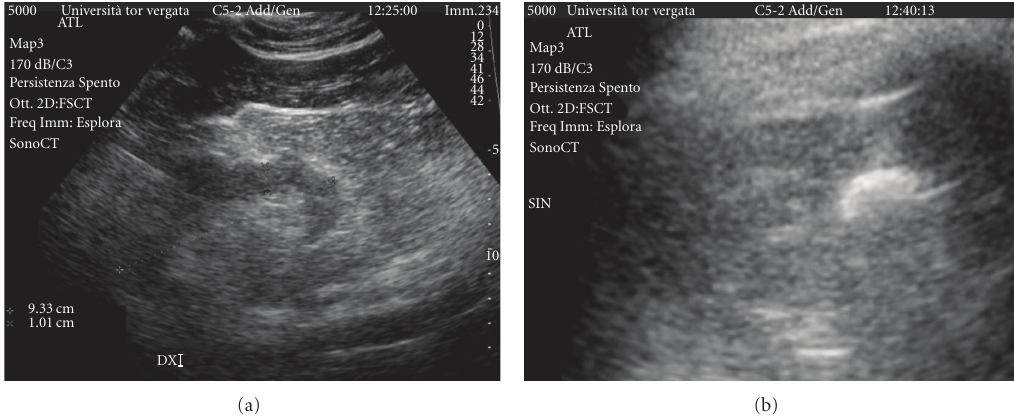
Figure 2: Ultrasonography imaging: normal right kidney (a) and absence of left kidney in the renal space (b).